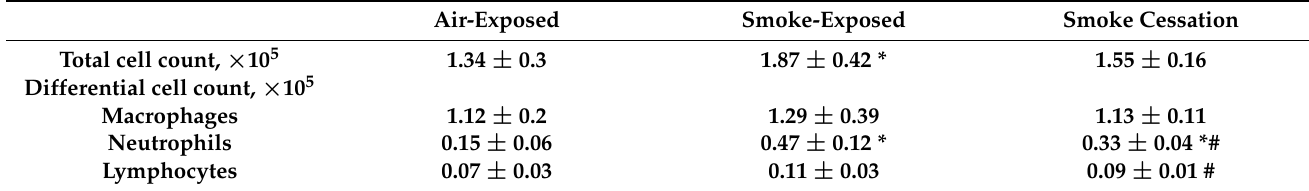
macrophages in lungs from mice left to rest in room air after 4 months of CS exposure; ( G ) real-time PCR analysis of mRNAs for KC carried out on lungs from 6 mice for each experimental group at various time points after the start of experiments. Values of transcripts for KC are corrected for 18S rRNA and normalized to a median control value of 1.0. Error bars indicate mean ± SD. * p < 0.05 vs. air controls; ( H ) ELISA analysis of KC in lung tissue and BAL fluids are reported. Error bars indicate